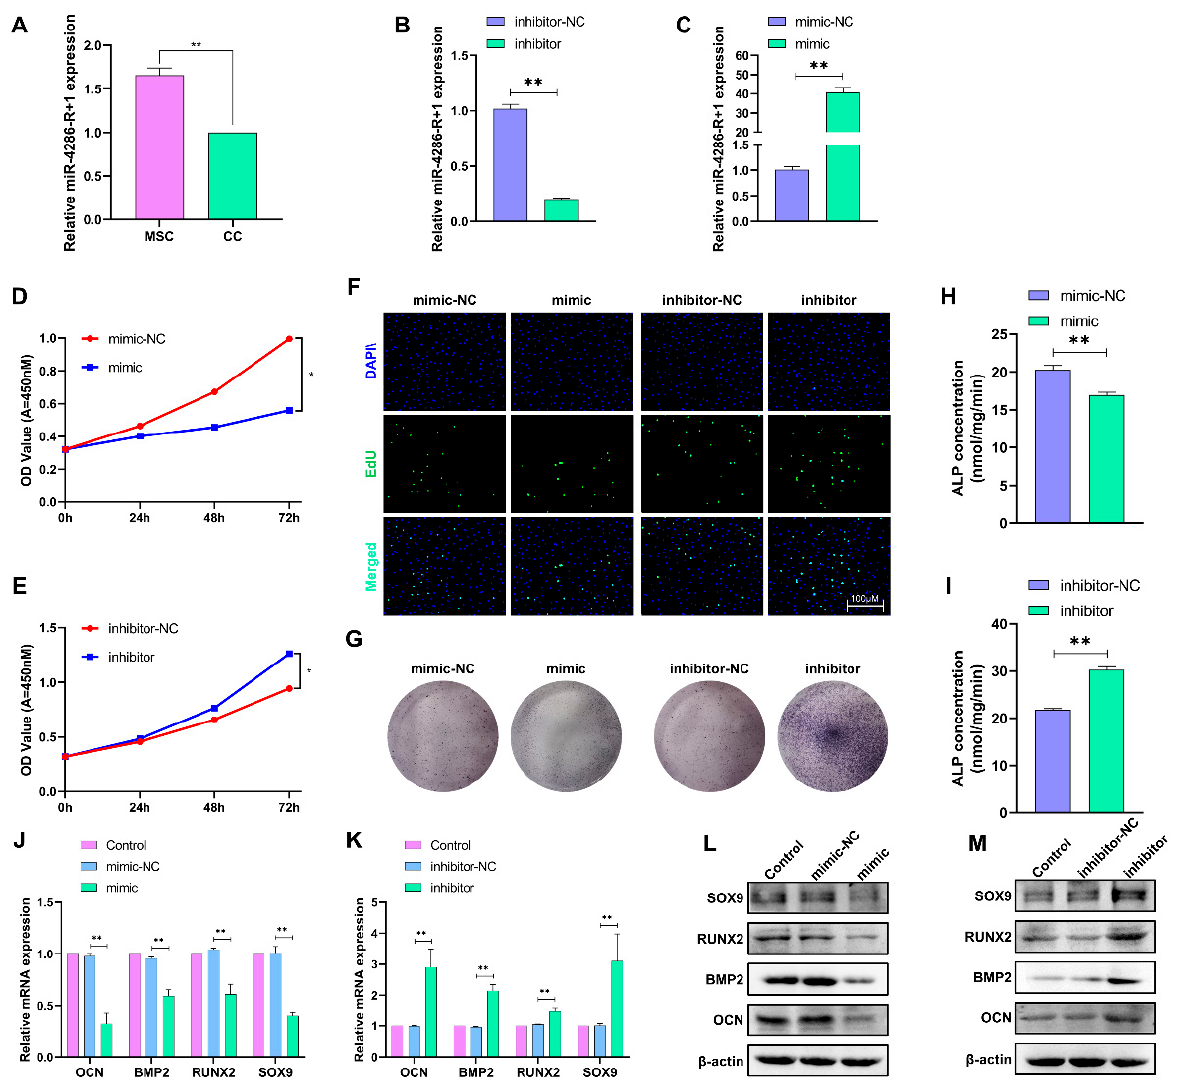
Figure 7. MiR-4286-R+1 inhibits chondrocyte proliferation and osteogenic differentiation. ( A , B ) Detection of miR-4286-R+1 expression level after transfection with mimic or inhibitor by RT-qPCR. ( C ) RT-qPCR detection of si-FOXO4 interference efficiency. After transfection of miR-4286-R+1 mimic or inhibitor in chondrocytes, CCK-8 ( D , E ) and EdU ( F ) were used to determine cell proliferation ability; BCIP/NBT staining ( G ) and ALP viability assay ( H , I ) to assess the osteogenic differentiation ability of chondrocytes; RT-qPCR ( J , K ) and Western blot ( L , M ) to detect changes in the transcriptional and translational levels of osteogenic marker-related genes. ** p < 0.01, * p < 0.05.